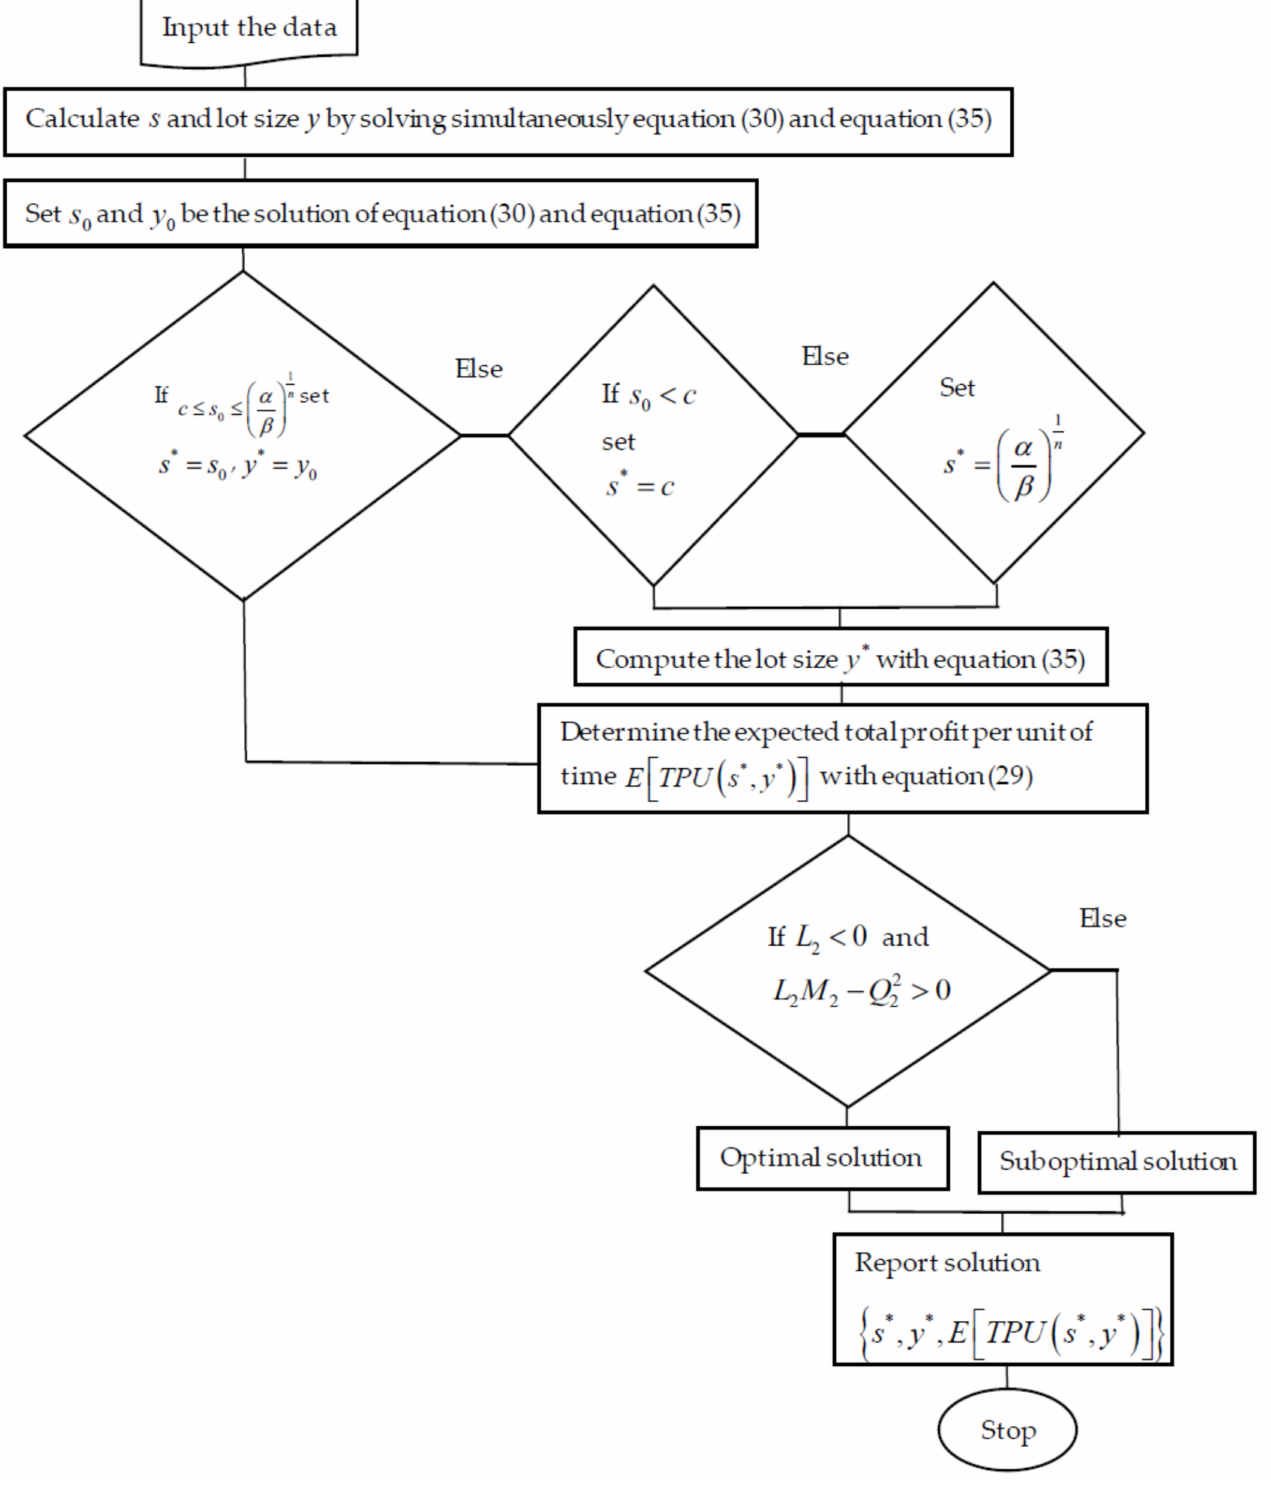
Figure 4. Flow chart of Algorithm